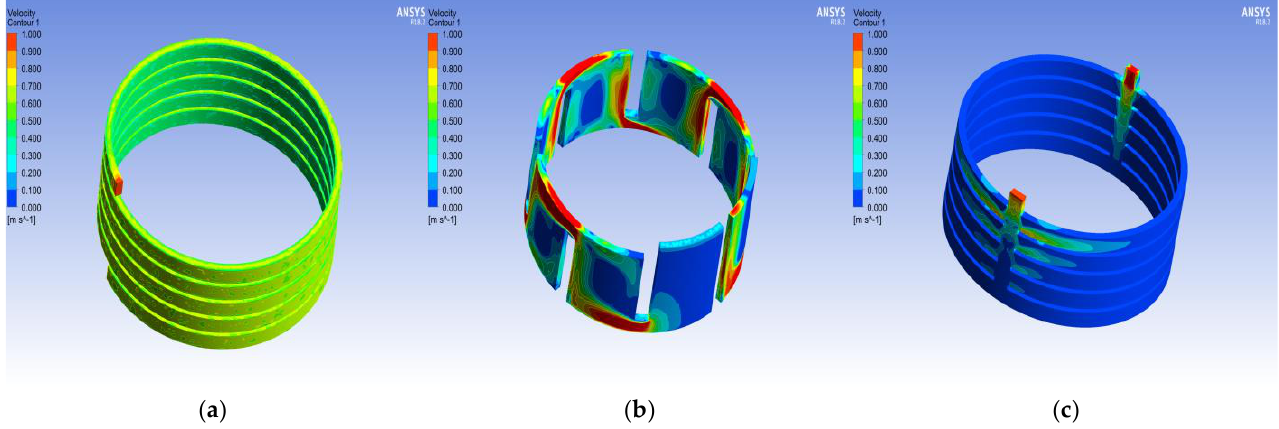
Figure 11. Velocity distribution with different types of housing cooling structures. ( a ) Spiral channel. ( b ) Axial channel. ( c ) Parallel channel. Table 5. Comparison of three types of housing cooling structures.